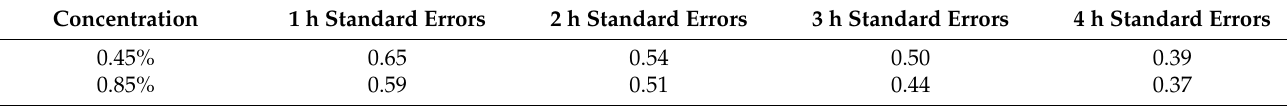
Table 1. Initial calculation for standard errors.